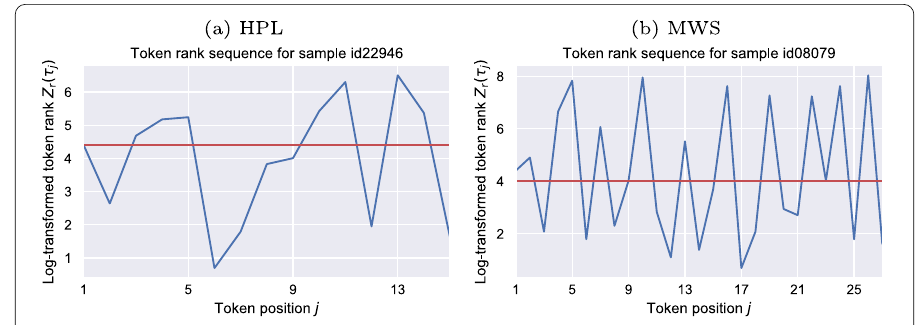
Figure 17 Token rank sequence examples for HPL and MWS. ( a ) Sample id22946 written by HPL. ( b ) Sample id08079 written by MWS. The red horizontal lines indicate the log-transformed median of the respective TRS. The value is 4.41 for id22946 and 4.03 for